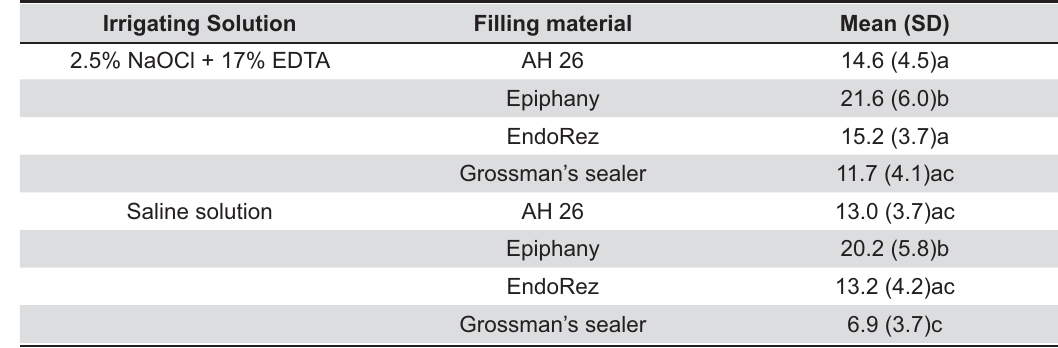
Table 1- (cid:2)(cid:3)(cid:4)(cid:5)(cid:6)(cid:2)(cid:7)(cid:8)(cid:9)(cid:10)(cid:2)(cid:11)(cid:6)(cid:2)(cid:3)(cid:12)(cid:5)(cid:2)(cid:13)(cid:14)(cid:15)(cid:2)(cid:4)(cid:5)(cid:16)(cid:17)(cid:2)(cid:18)(cid:15)(cid:14)(cid:19)(cid:20)(cid:2)(cid:21)(cid:4)(cid:22)(cid:21)(cid:4)(cid:23)(cid:24)(cid:2)(cid:3)(cid:4)(cid:5)(cid:6)(cid:22)(cid:2)(cid:25)(cid:11)(cid:21)(cid:17)(cid:2)(cid:22)(cid:11)(cid:26)(cid:11)(cid:27)(cid:5)(cid:15)(cid:2)(cid:22)(cid:19)(cid:20)(cid:4)(cid:15)(cid:22)(cid:16)(cid:15)(cid:11)(cid:20)(cid:21)(cid:2)(cid:22)(cid:28)(cid:26)(cid:29)(cid:14)(cid:27)(cid:22)(cid:2)(cid:11)(cid:6)(cid:23)(cid:11)(cid:16)(cid:5)(cid:21)(cid:4)(cid:2)(cid:6)(cid:14)(cid:6)(cid:30)(cid:22)(cid:11)(cid:18)(cid:6)(cid:11)(cid:31)(cid:16)(cid:5)(cid:6)(cid:21)(cid:2)(cid:23)(cid:11)(cid:13)(cid:13)(cid:4)(cid:15)(cid:4)(cid:6)(cid:16)(cid:4)(cid:22)(cid:2)